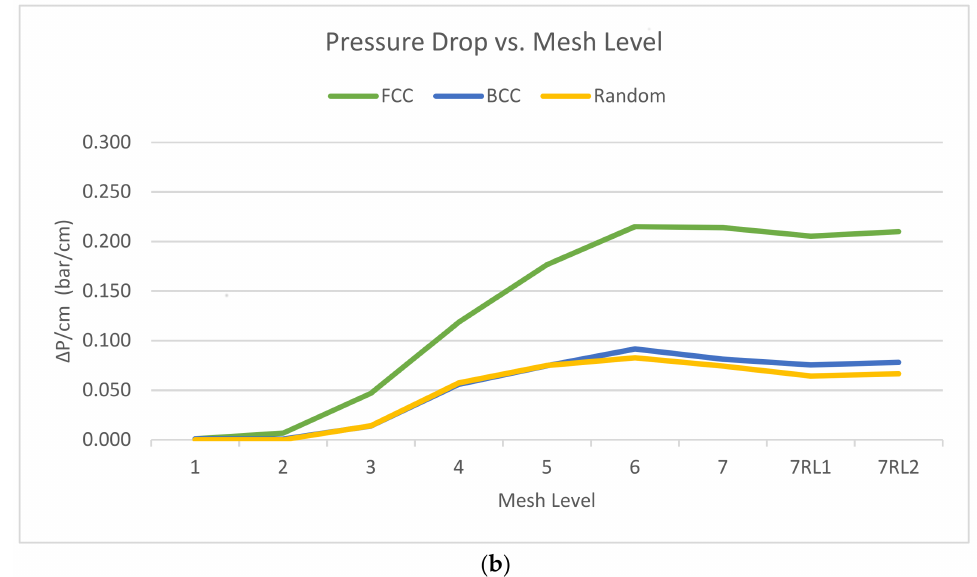
Figure 9. ( a ) Calculated volume in flow simulation for three bed structures as a function of mesh level; ( b ) Pressure drop for three bed structures as a function of mesh level.